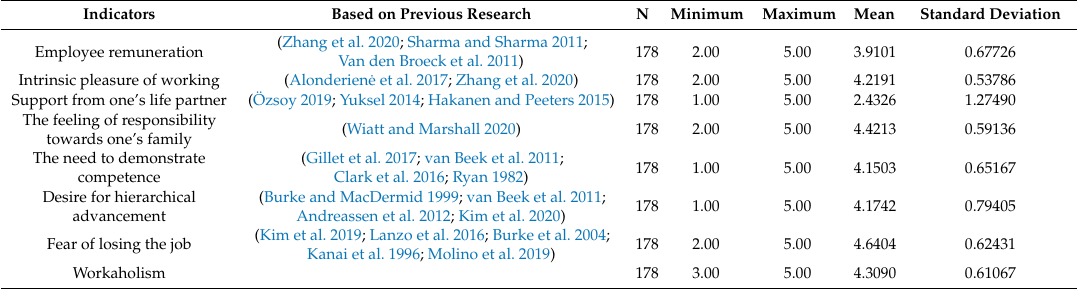
Table 4. Independent and dependent variables in the IT industry—descriptive statistics.